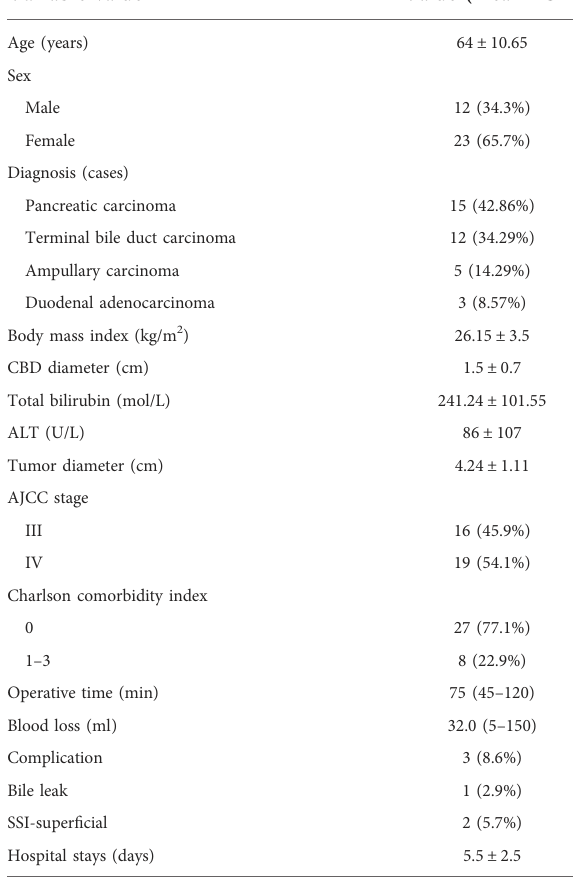
TABLE 1 Patient and surgery